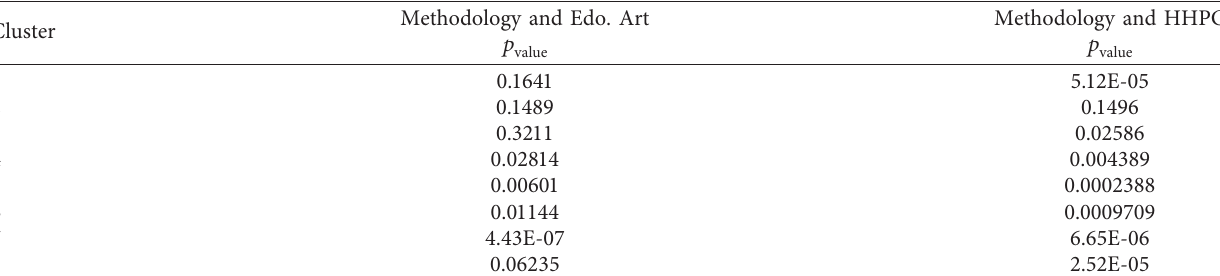
Table 21: Results of the Student t -tests for methodology and Edo. Art and methodology and HHPC.